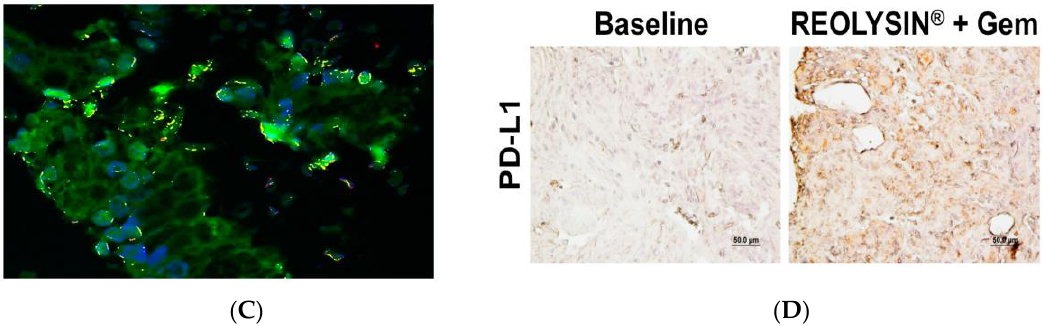
Figure 2. Tumor biopsy from the primary pancreatic tumor of a single patient with a KRAS G12D mutation following treatment with pelareorep and gemcitabine. ( A ) Immunohistochemistry (IHC) analysis of HCT116 colon cancer cells treated with pelareorep serves as a positive control for reoviral protein replication (brown). The uninfectecd HCT116 cell line is the negative control (inset); ( B ) IHC shows positive staining for reoviral protein and activated caspase-3 protein localized to cancer cells; ( C ) Fluorescent in situ hybridization (FISH) demonstrates coexpression of reoviral protein and caspase-3 consistent with productive lytic infection in the patient’s tumor. Yellow indicates colocalizaiton of reovirus (green) and caspase-3 (red) in the same cancer cells; ( D ) analysis of the tumor also reveals upregulation of programmed death ligand 1 (PD-L1) on IHC following pelareorep therapy (left panel represents the baseline; right panel represents pelareorep with gemcitabine). Scale bar: 50 µm.